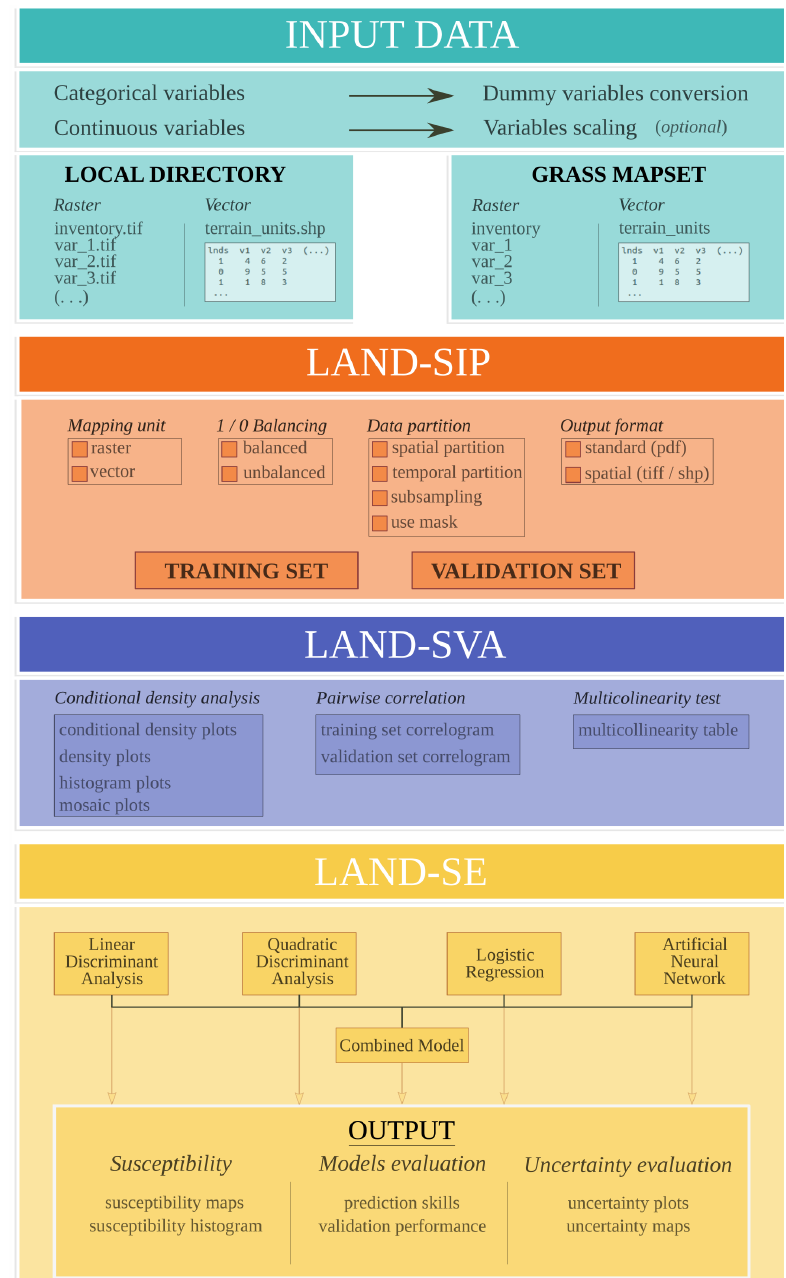
Figure 1. Logical schema of LAND-SUITE